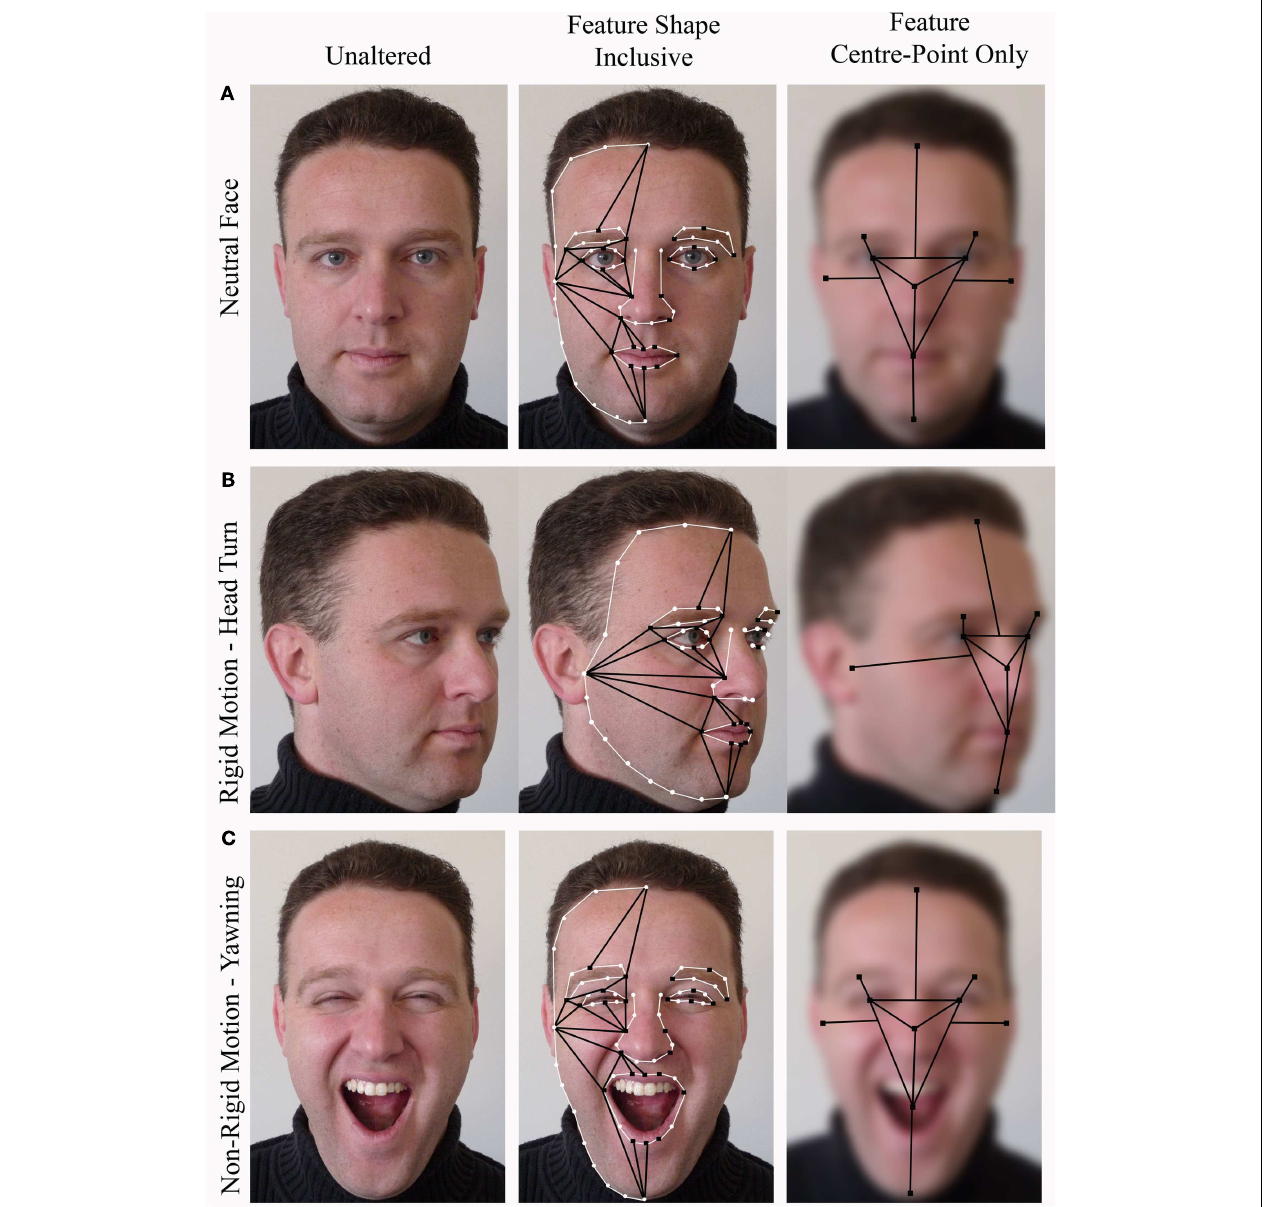
information is calculated, black lines represent configural information, white circles represent other contour points, and white lines follow the shapes of the features. Center-point only images have been blurred to emphasize that feature shape does not factor into the holistic representation in this